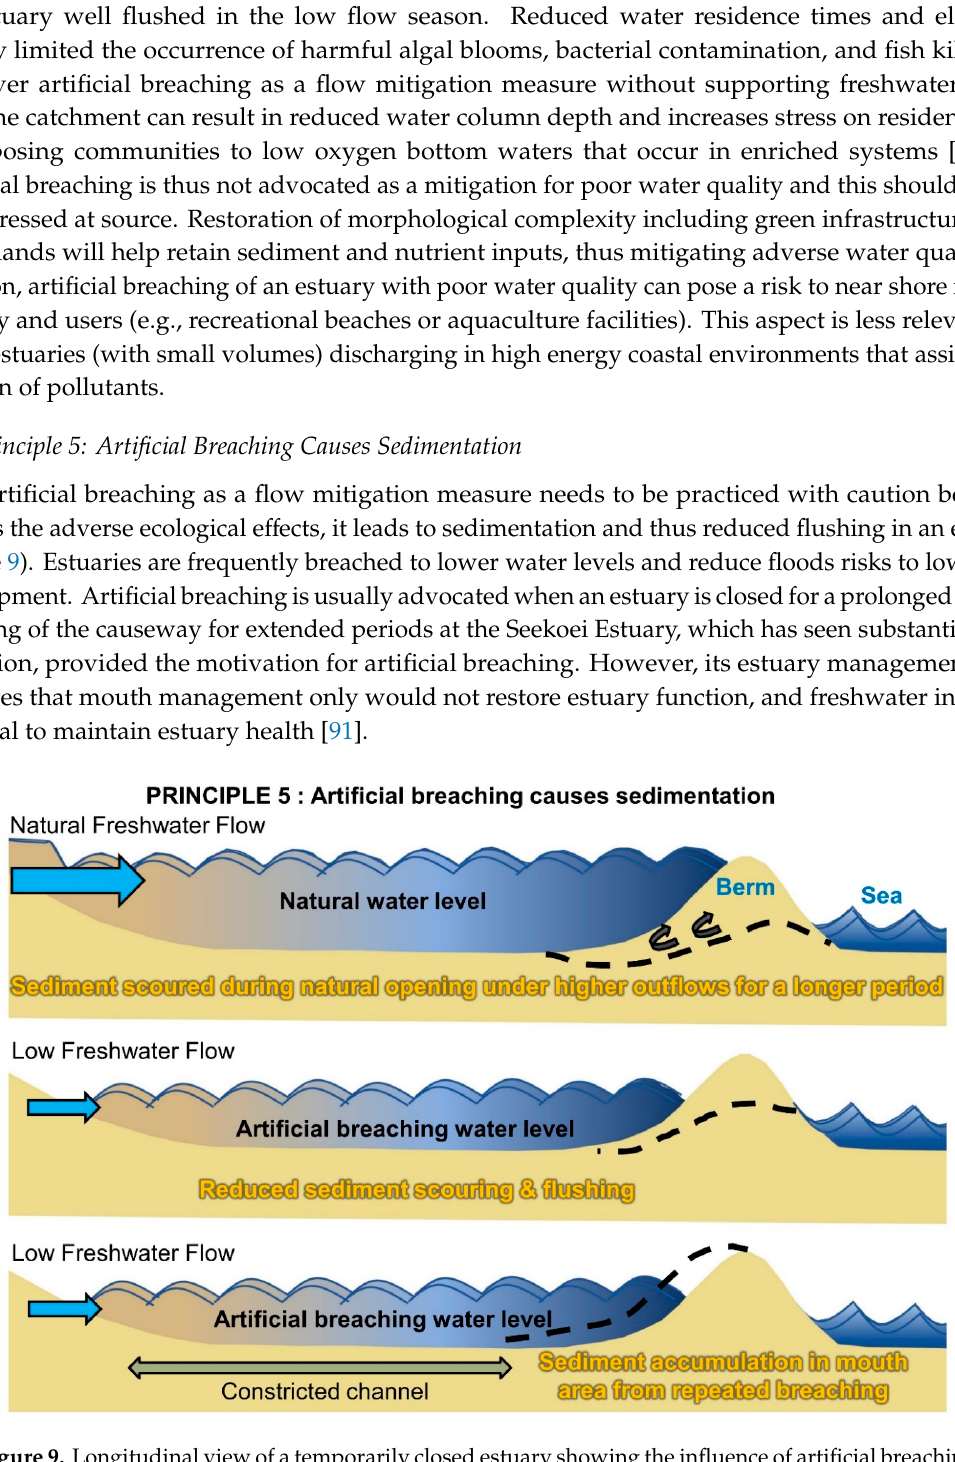
Figure 9. Longitudinal view of a temporarily closed estuary showing the influence of artificial breaching on sediment scouring and flushing.